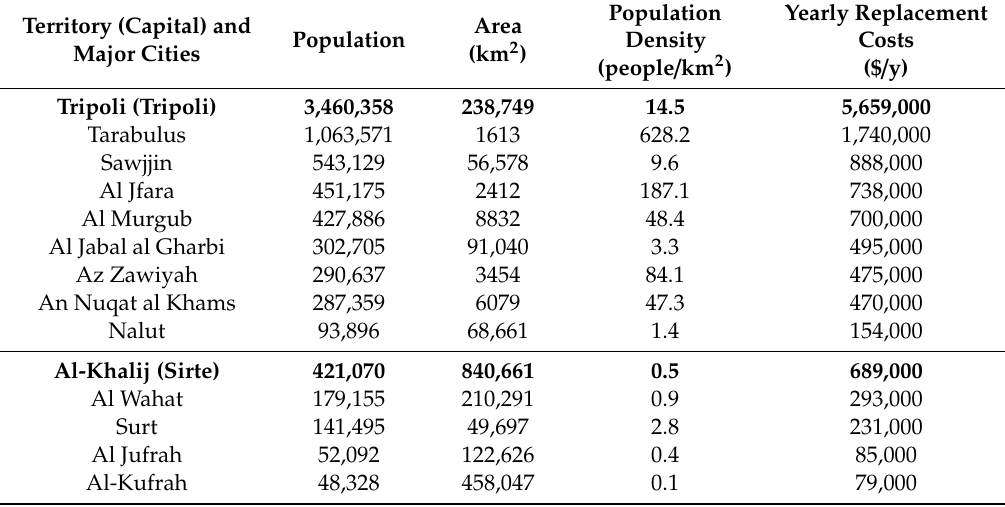
Table 10. The yearly replacement costs of K (based on a moving 5-year average price of U.S. $500 per metric ton of potassium chloride, KCl [27]) using the kg / y values reported in Table 11 the each of the Libyan territories and the capital and major